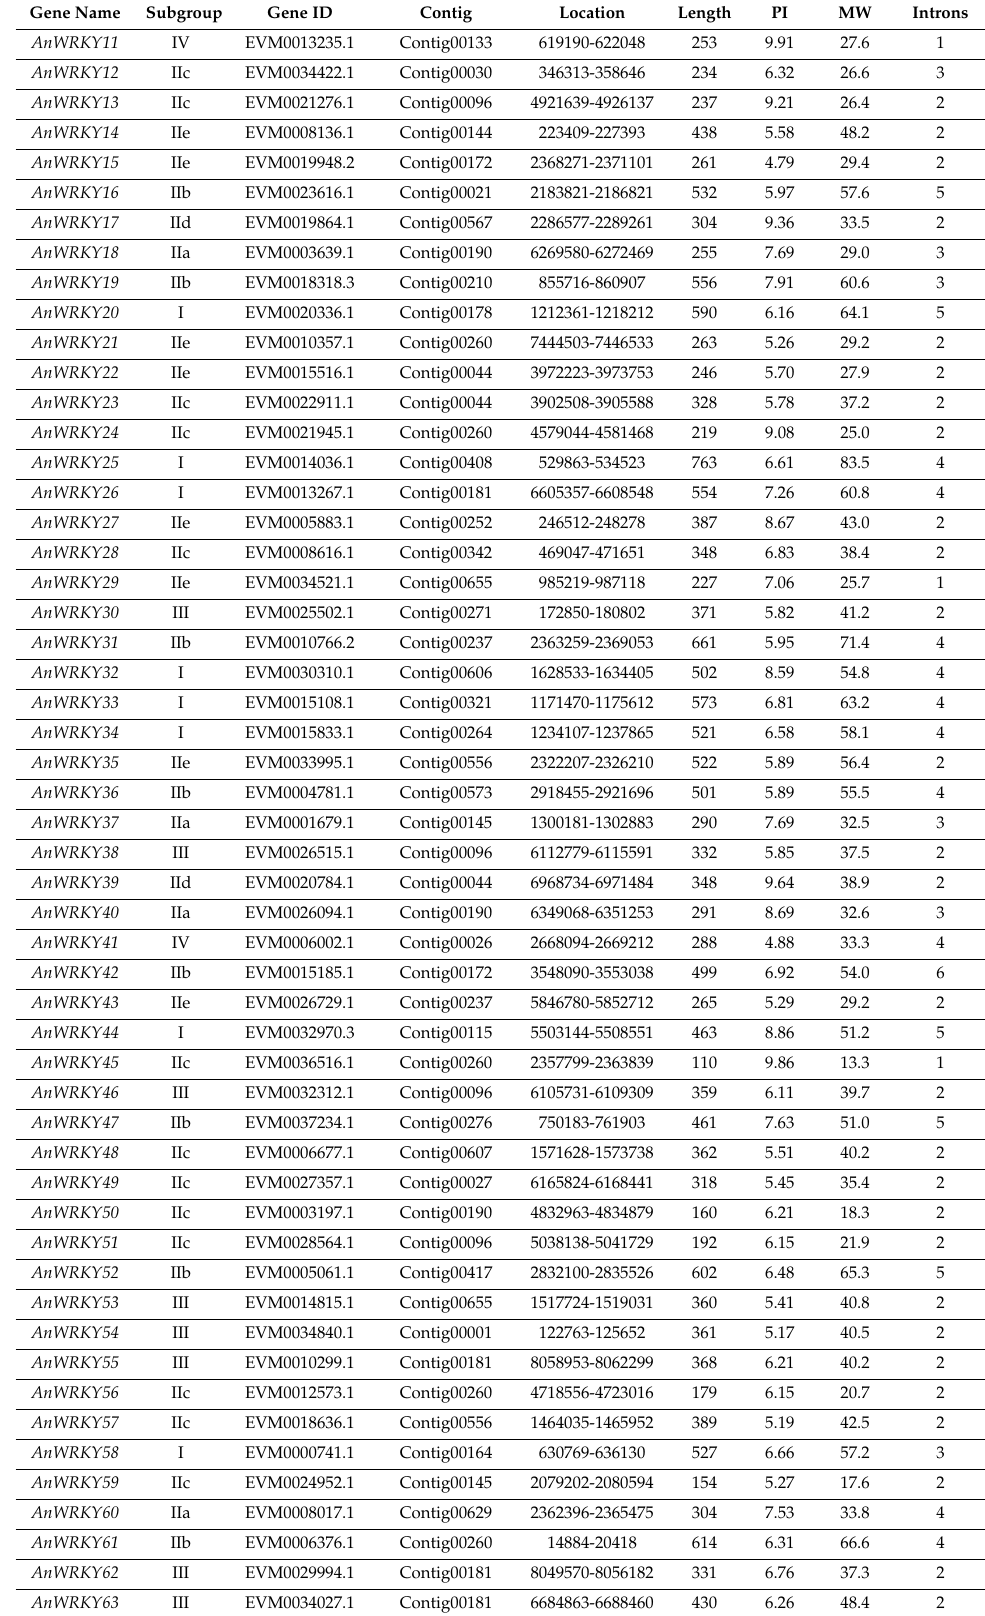
Table 2. A. nanus WRKY genes and their